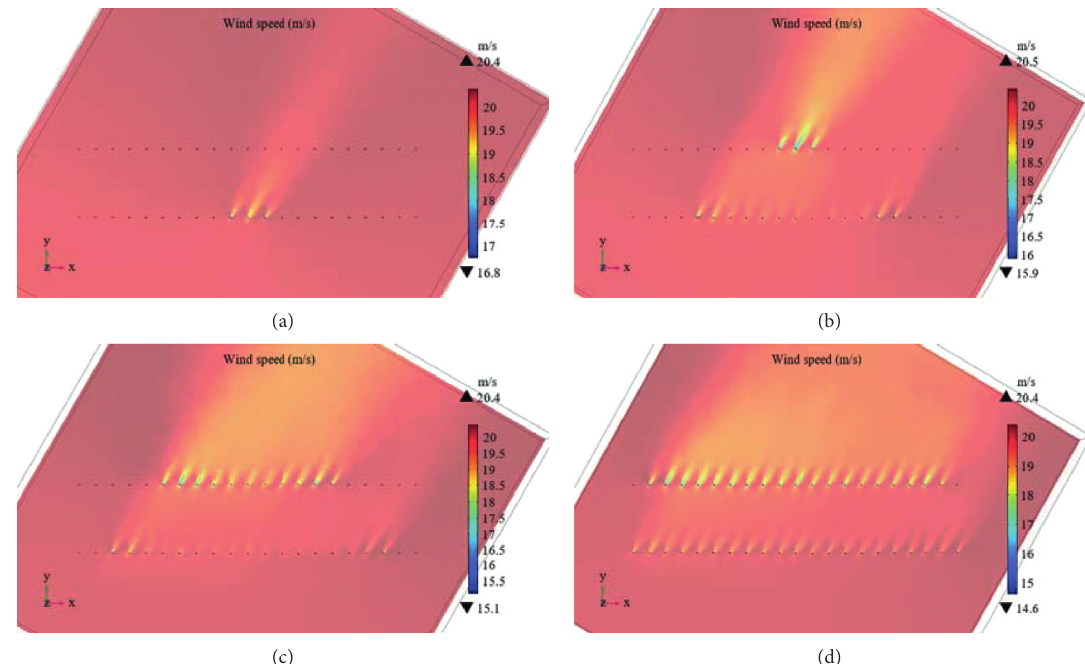
Figure 7: Influence of height for wind field (wind direction � 60 ° /120 ° ). (a) 60 ° /120 ° , z � 10m. (b) 60 ° /120 ° , z � 5m. (c) 60 ° /120 ° , z � 3m. (d) 60 ° /120 ° , z � 1